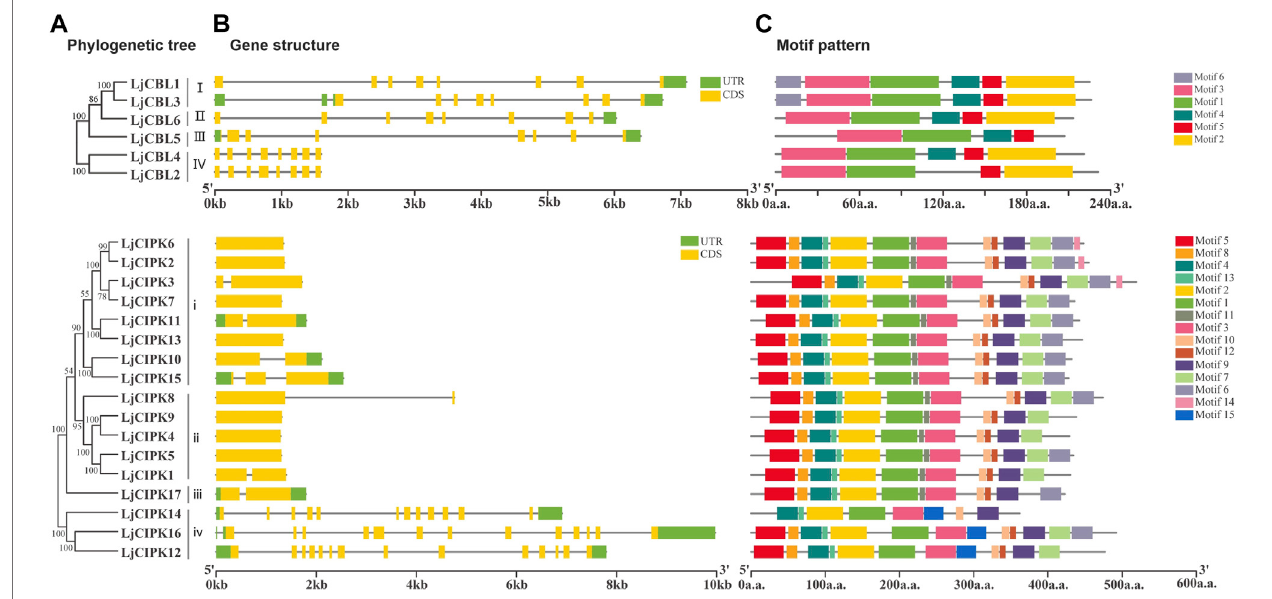
FIGURE 3 | Phylogenetic relationships(A), gene structure(B), and conserved motifs(C) in CBL-CIPK genes from honeysuckle (A) Phylogenetic relationships (B) gene structure. Green boxes indicate untranslated 5 ′ - and 3 ′ -regions, yellow boxes indicate exons, and black lines indicate introns. The length of the protein can be estimatedusingthescaleatthebottom (C) Conservedmotifs.Themotifsaredisplayed indifferentcoloredboxes.Thesequenceinformationforeachmotifisprovidedin Supplementary Table S1, Sheet 6 and Supplementary Figures S1,S2